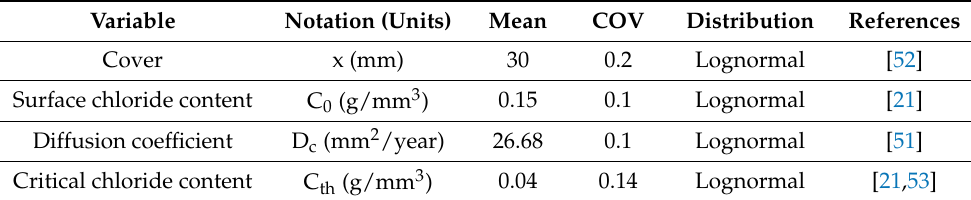
Table 3. Values and probabilistic descriptors of parameters used in Equation (A1).